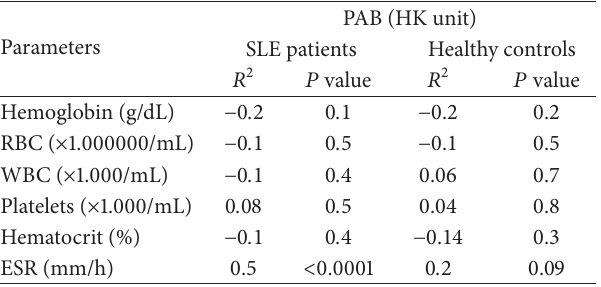
Table 2: Correlation of PAB values and laboratory findings in patients with SLE and healthy controls.